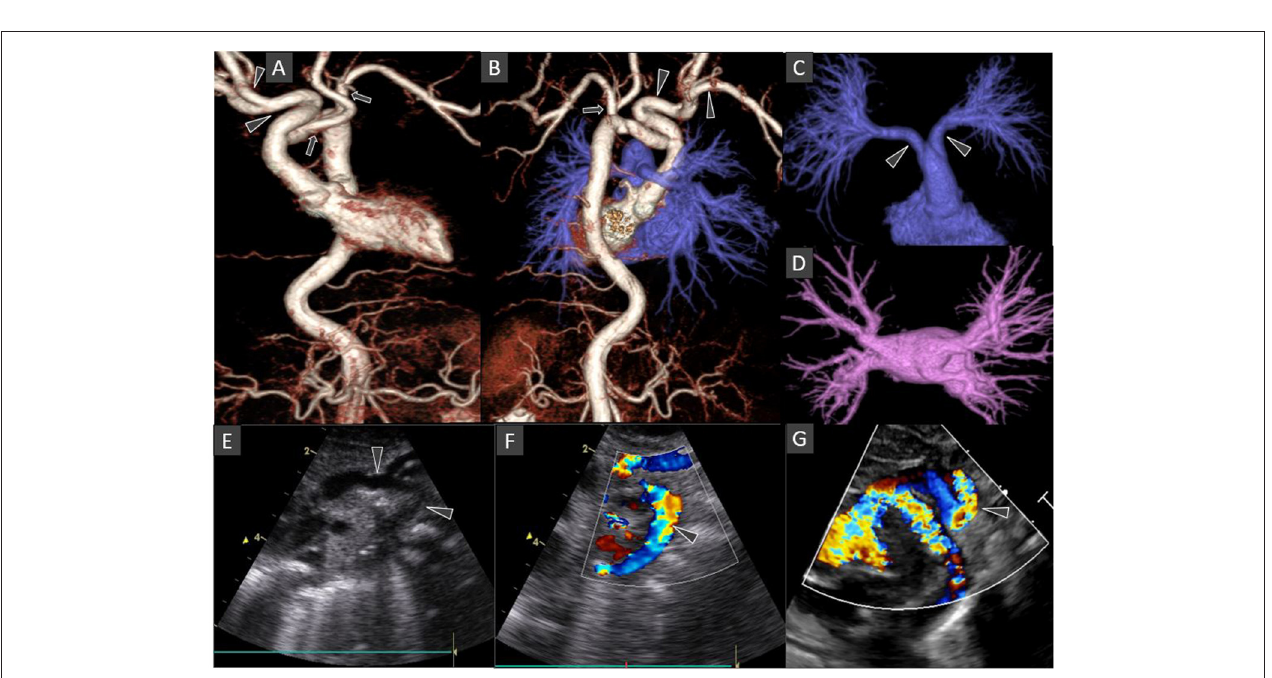
FIGURE 2 | Chest CT Angiography 3D surface shaded display images: Anterior view of the thoraco-abdominal aorta (A) ; Posterior view of the combined thoraco-abdominal aorta and pulmonary arteries (B) ; Antero-superior view of the subtracted pulmonary arterial circulation and right atrium (C) ; Superior view of the subtracted pulmonary venous circulation and left atrium (D) . Oblique coronal gray-scale (E) ; and color Doppler (F,G) echocardiography images of the aortic arch and its major branches. The left-sided aortic arch has an unusual configuration with the dilated innominate artery forming a hairpin turn before its bifurcation into right subclavian and common carotid arteries (arrowheads in A,B ). The left common carotid and subclavian arteries arise from the hypoplastic mid arch (arrows in A,B ). The thoraco-abdominal aorta is tortuous. Included abdominal aorta shows dilated and tortuous branches of the coeliac axis. The main pulmonary artery is short with early bifurcation with long tubular configuration and parallel proximal course of the right and left main pulmonary arteries (arrowheads in C ). Normal morphology of bilateral pulmonary veins draining into the left atrium (D) . Some of these findings are also demonstrated on echocardiography images (arrows in E–G ).